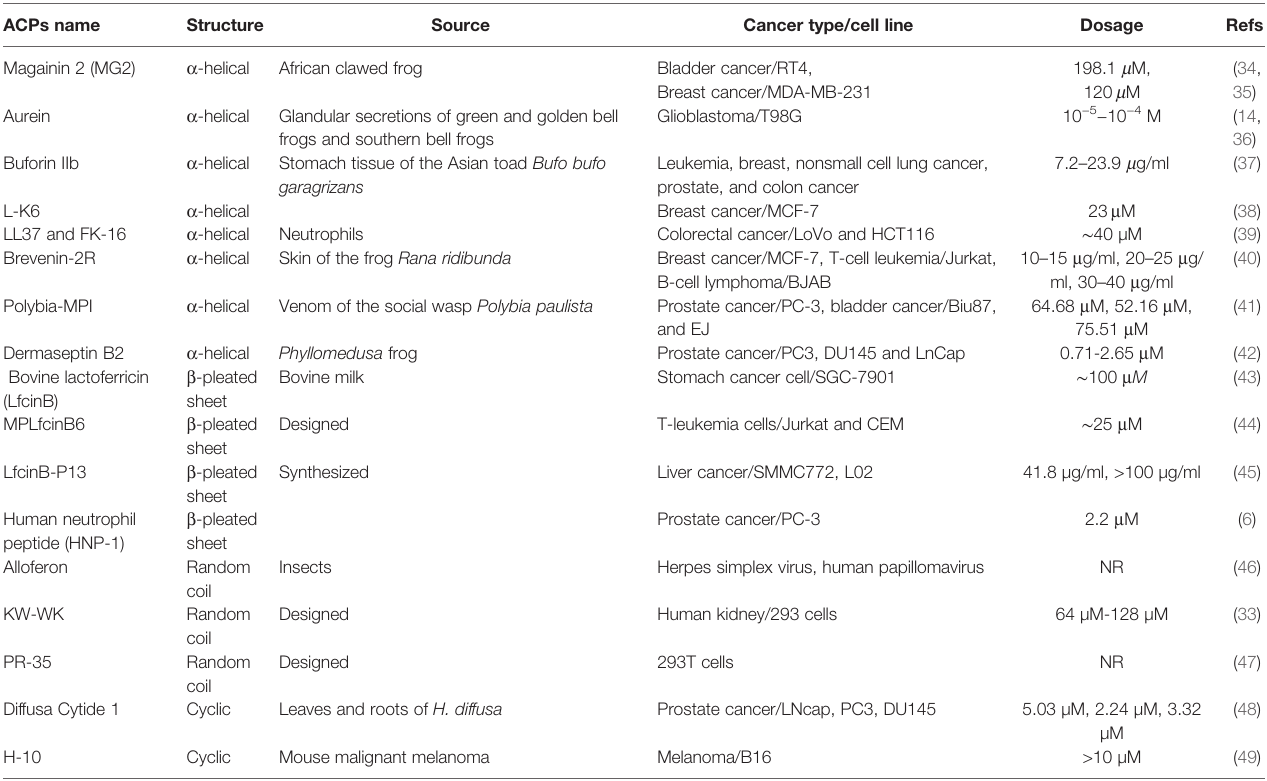
TABLE 1 | Some anticancer peptides with different structures and